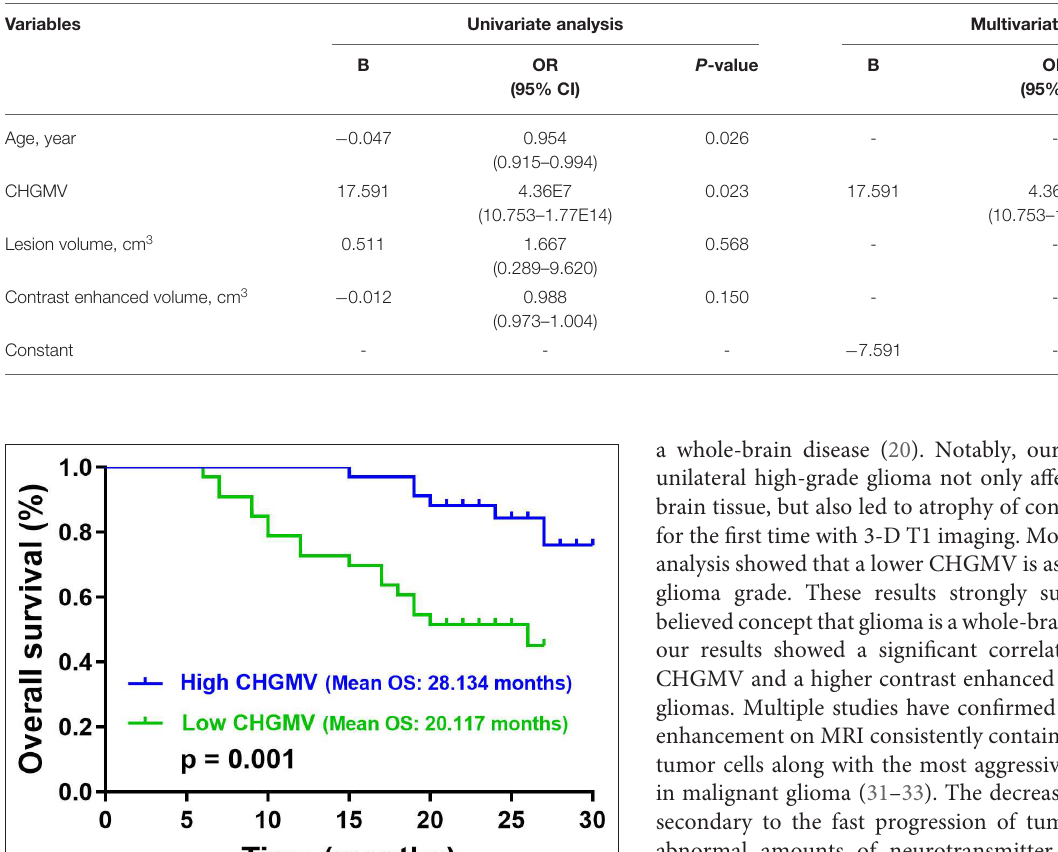
TABLE 3 | Univariate and multivariate logistic regression analysis of variables to predict P53